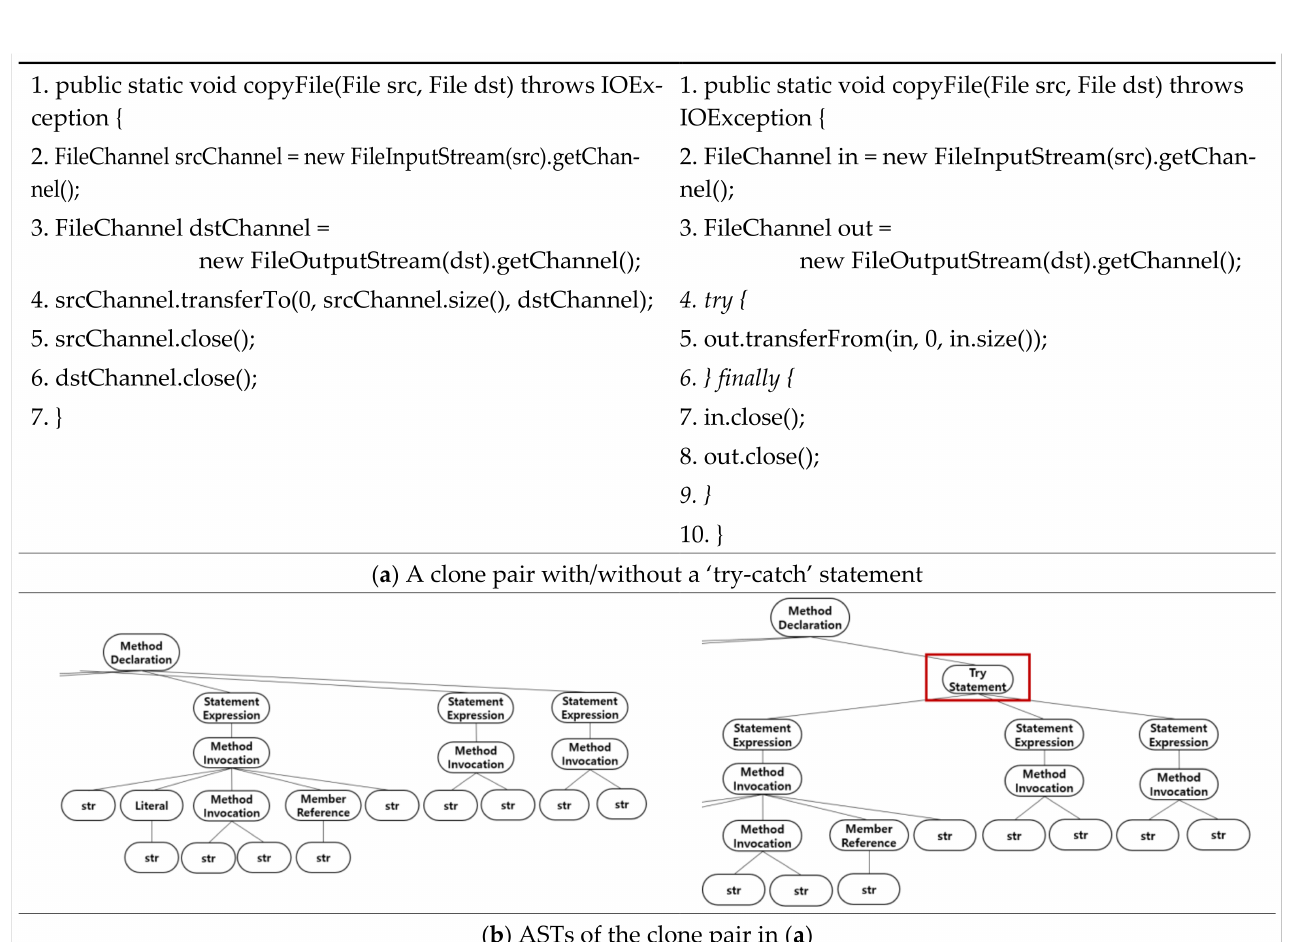
Figure 7. Example of ST3 clone classified as MT3